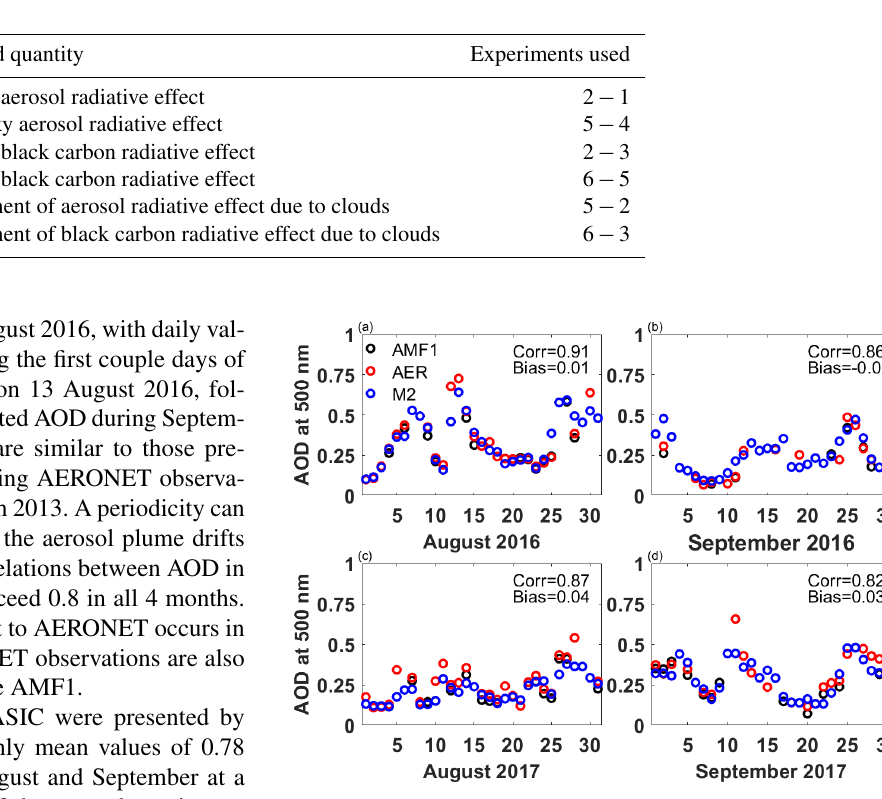
Figure 1. Daily mean aerosol optical depth from the AMF1 (black), AERONET (AER; red), and MERRA-2 (M2; blue) at Ascension Is- land during (a) August 2016, (b) September 2016, (c) August 2017, and (d) September 2017. Correlation and bias for MERRA-2 are with respect to AERONET